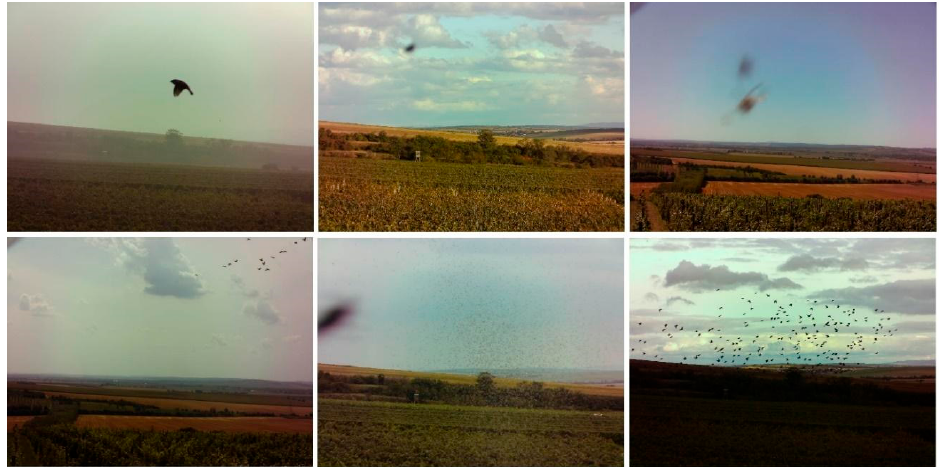
Figure 6. Examples of images capturing the activity in a vineyard.